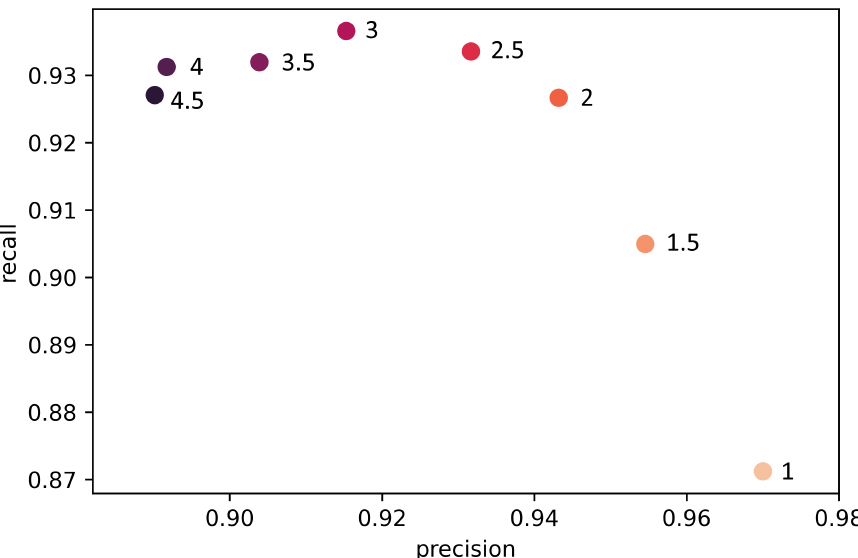
Figure 10. Relationship between γ , precision, and recall with median values of the training results on the validation